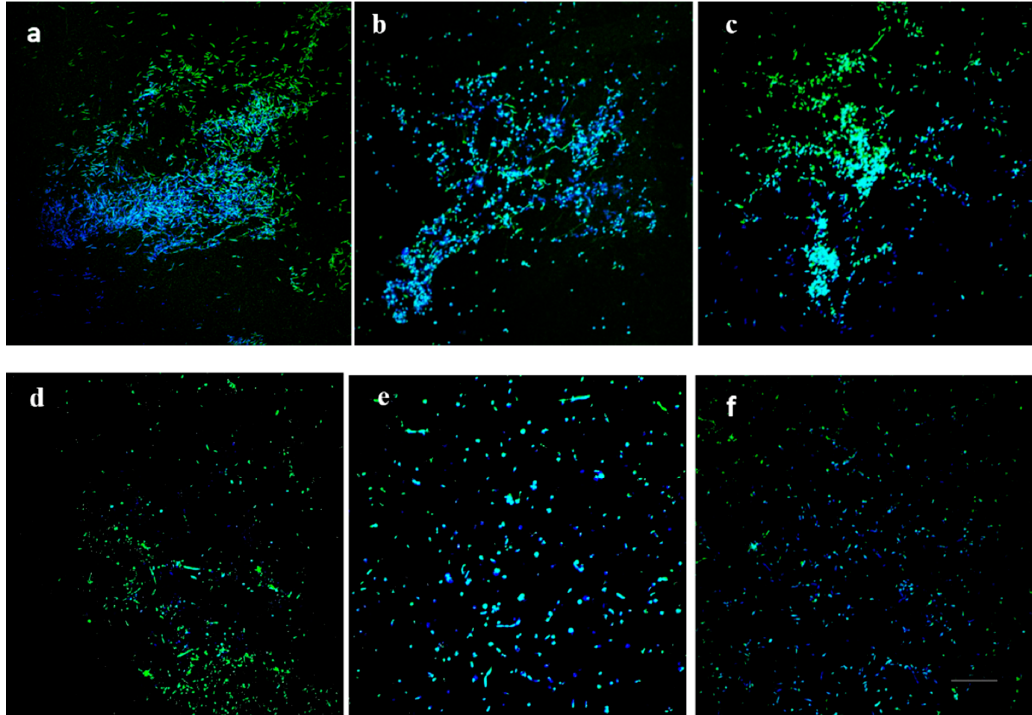
Figure 6. Confocal scanning laser microscopy images of C. jejuni 11168-O biofilm in presence of 25 mM of DAs. C. jejuni biofilm at 48 h, imaged using dual fluorescence labelling by confocal laser scanning microscopy (CLSM). ( a ) Untreated, ( b ) D-ala, ( c ) L-ala, ( d ) D-ser, ( e ) D-met, ( f ) D-trp. Cells were stained with 4 (cid:48) ,6-diamidino-2-phenylindole (DAPI, blue) and amyloid fibrils by Thioflavin T (ThioT, green) (Scale bar = 20 µ